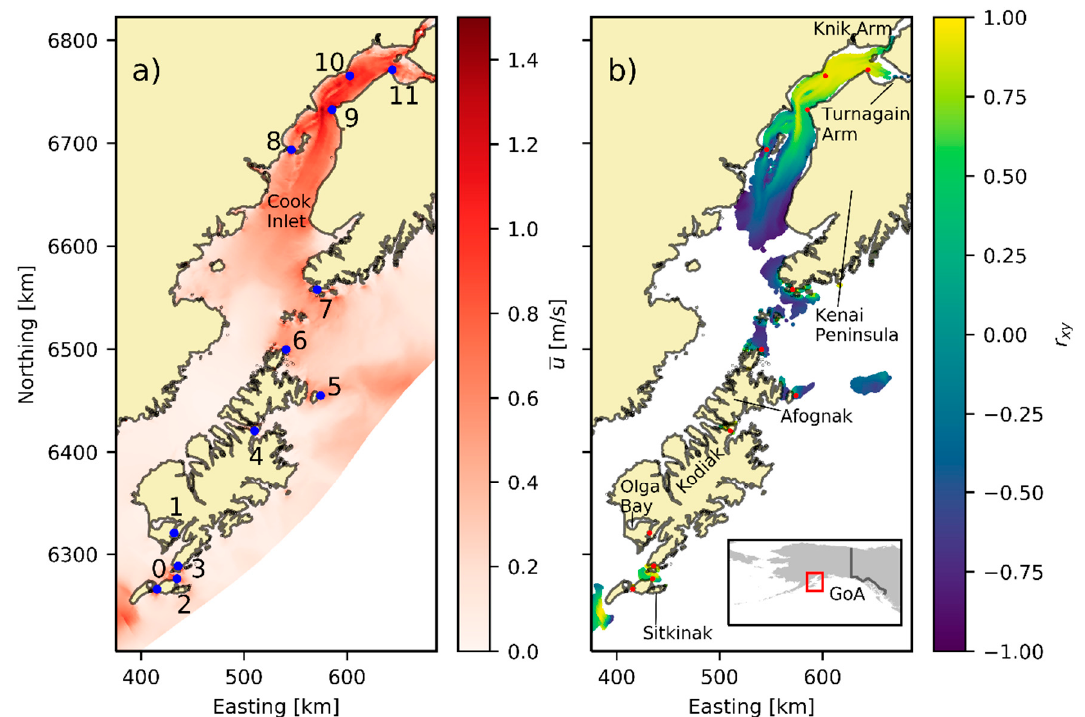
Figure 3. Cook Inlet and Kodiak study area. ( a ) Mean tidal current speed and ( b ) cross-correlation at points with mean velocity above 50 cm / s and deeper than 10 m with respect to the anchor point (0). Representative points for the correlation analysis are identified on both panels. GoA stands for Gulf of Alaska.